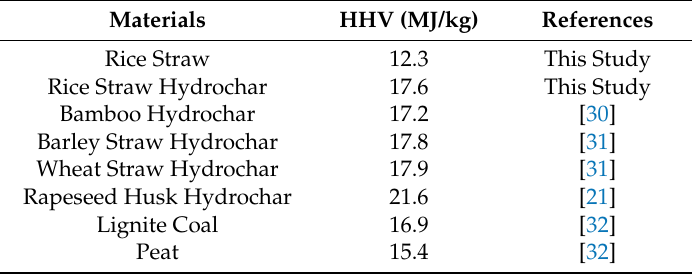
Table 4. The higher heating valuse (HHV) (MJ/kg) of rice straw, the optimized hydrochar, the different hydrochars synthesised by MIHTC and various coal